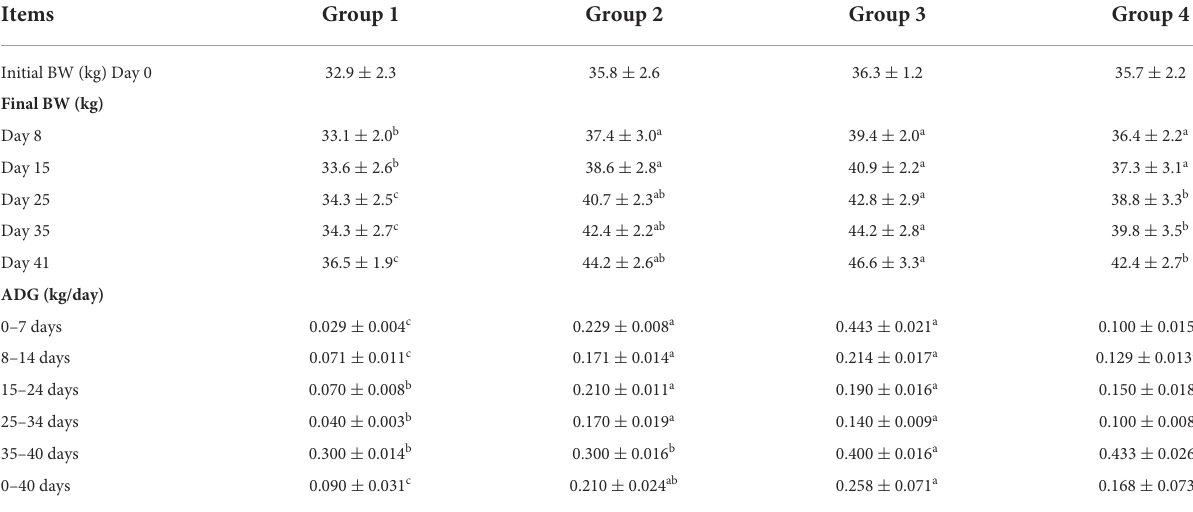
TABLE 2 Effects of alfalfa saponins on growth performances (mean ± SD) of Small-Tailed Han sheep.